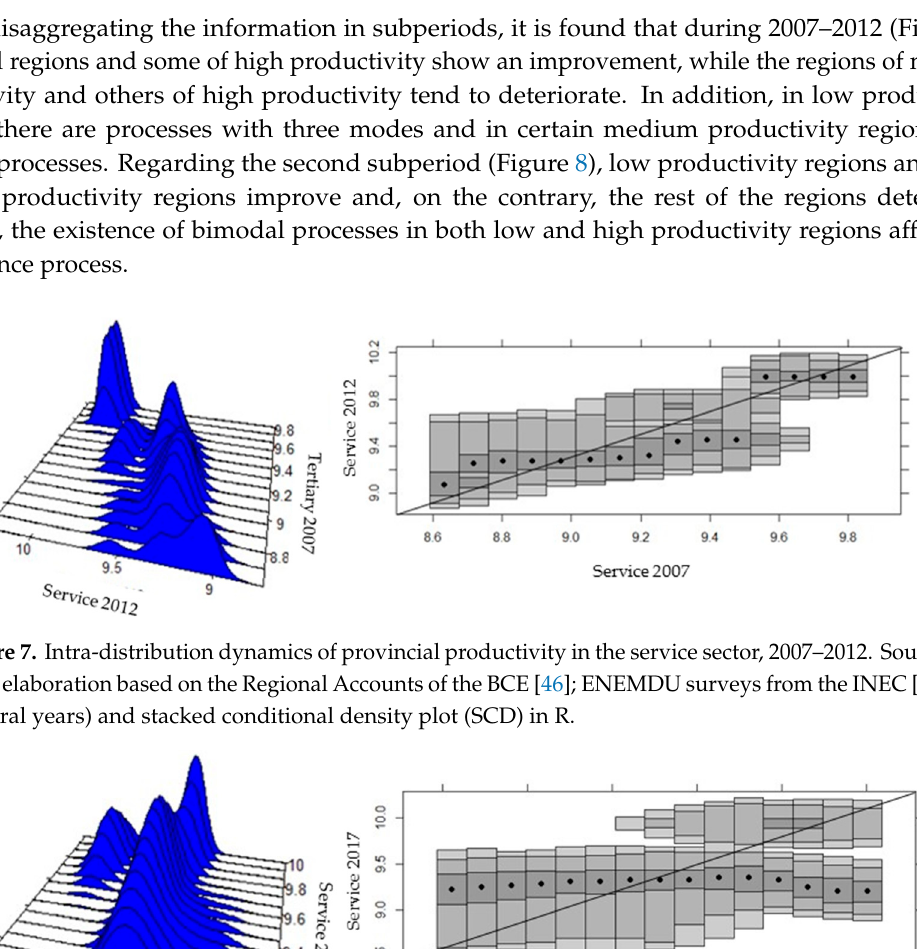
Figure 8. Intra-distribution dynamics of provincial productivity in the service sector, 2012–2017. Source: Own elaboration based on the Regional Accounts of the BCE [46]; ENEMDU surveys from the INEC [47] (several years) and stacked conditional density plot (SCD) in R.